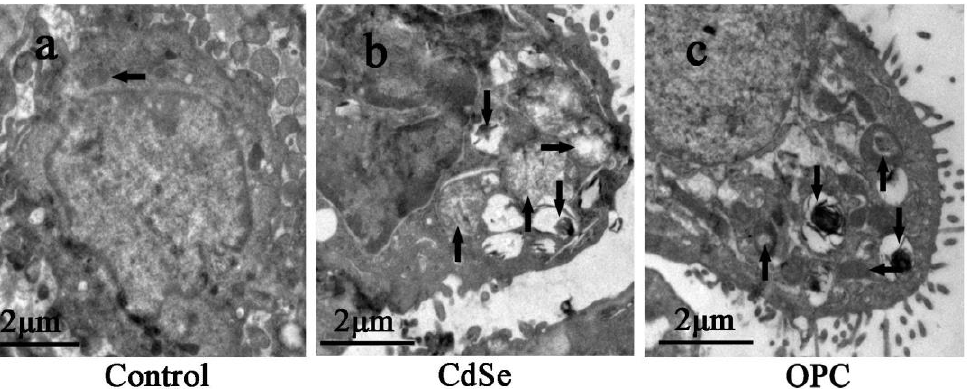
Figure 6. TEM images of ultrathin sections made with alveolar macrophage in the lung tissues. ( a ) the control group with normal mitochondria (left arrow); ( b ) the CdSe group, mitochondrial cristae broken, swelling (up arrows), and vacuolization (right arrows), numerous secondary lysosome containing aggregated CdSe nanorods (down arrows) were observed; ( c ) the OPC group, mitochondria became slightly swelling, less vacuolization (up arrows) were observed, secondary lysosome (down arrows) and normal mitochondria (left arrow) were also observed. The above typical pictures are selected from the lung tissues of eight rats in each group.